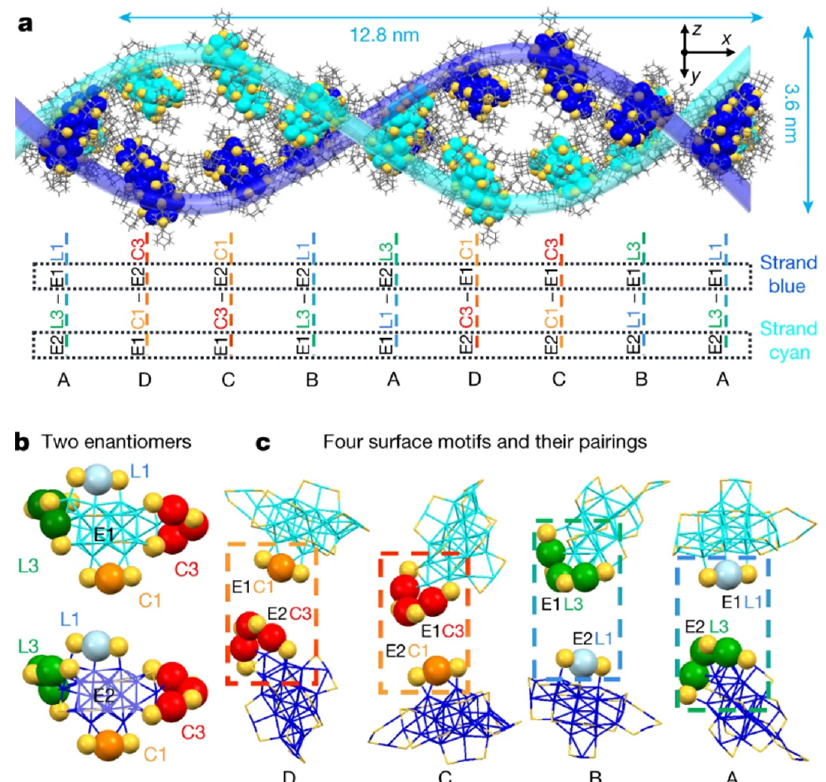
Figure 1. ( a ) Two enantiomers of Au 29 (SR) 19 in supercrystal (E1 and E2); ( b ) The enantiomers contain four distinct major motifs, denoted as L1 and L3, C1 and C3; ( c ) Four types of motif matching between adjacent enantiomers in the supercrystal. Copyright 2021 Springer Nature.